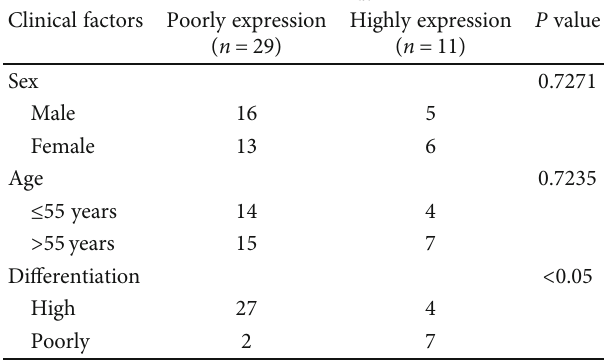
Table 4: The relationship between PPAR α expression and some clinical factors of ccRCC patients ( n = 40 , chi-square